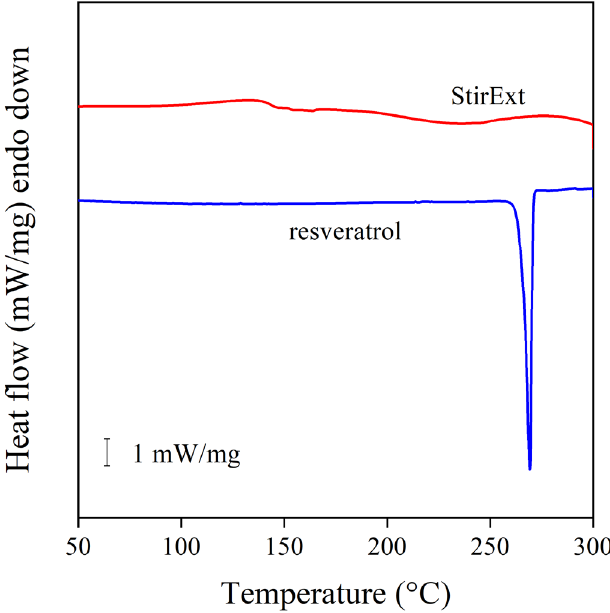
Figure 4. Comparison of the DSC thermogram of trans -resveratrol and the extract obtained by stirred extraction. Heating at 10 ◦ C/min rate in